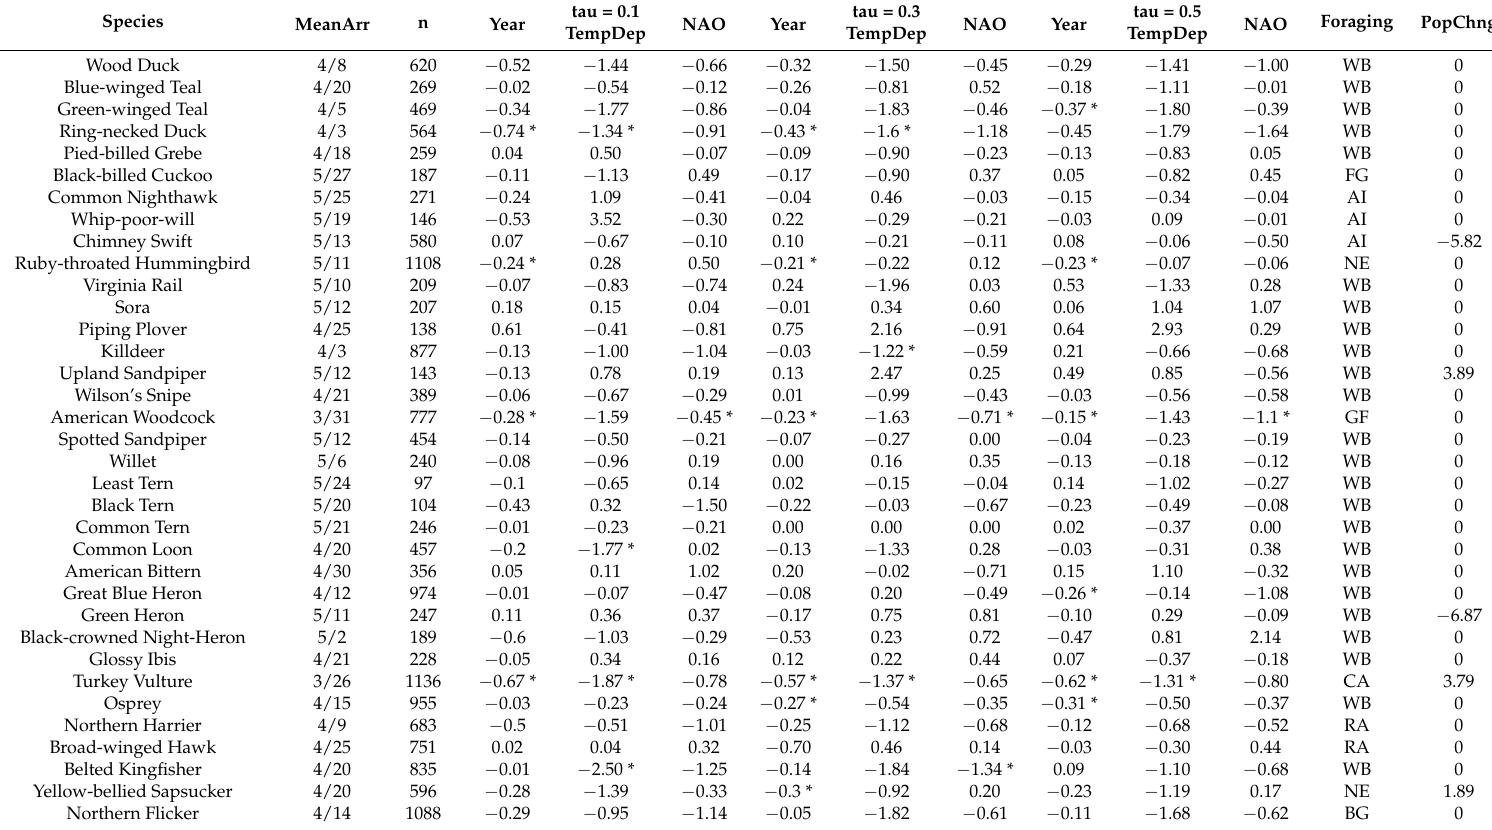
Table 4. Results of quantile regressions testing the effect of time (Year) on arrival dates. The data presented are the regression coefficients for each independent variable. The Benjamini-Hochberg adjustment was used to correct for false discovery rates. Asterisks indicate a significant effect ( p < 0.05) after correction. Data are given for three sets of quantile regressions with tau set to 0.01, 0.03 and 0.05. Foraging types are based on Ehrlich and Dobkin (1975). Key to abbreviations: